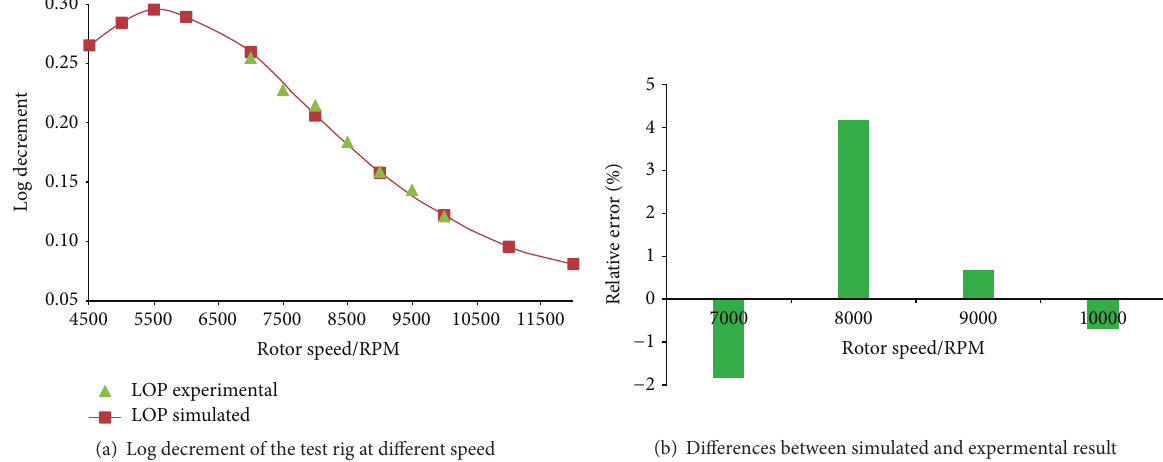
Figure 9: Log decrement of the rotor at different rotating speed for LOP configurations (comparison between theory and experiment, preload 0.1).